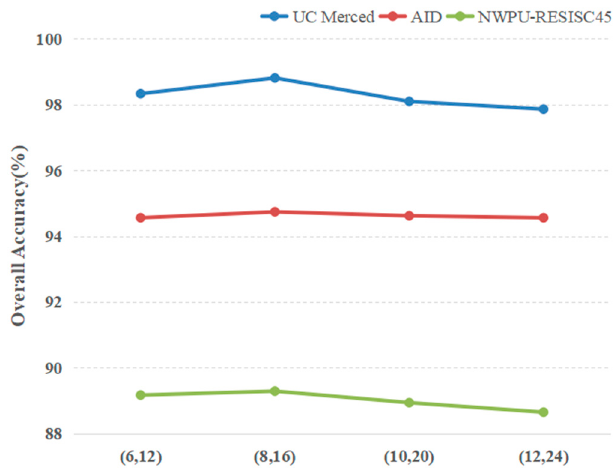
Figure 13. The influence of the dimension of the capsule on the classification accuracy.